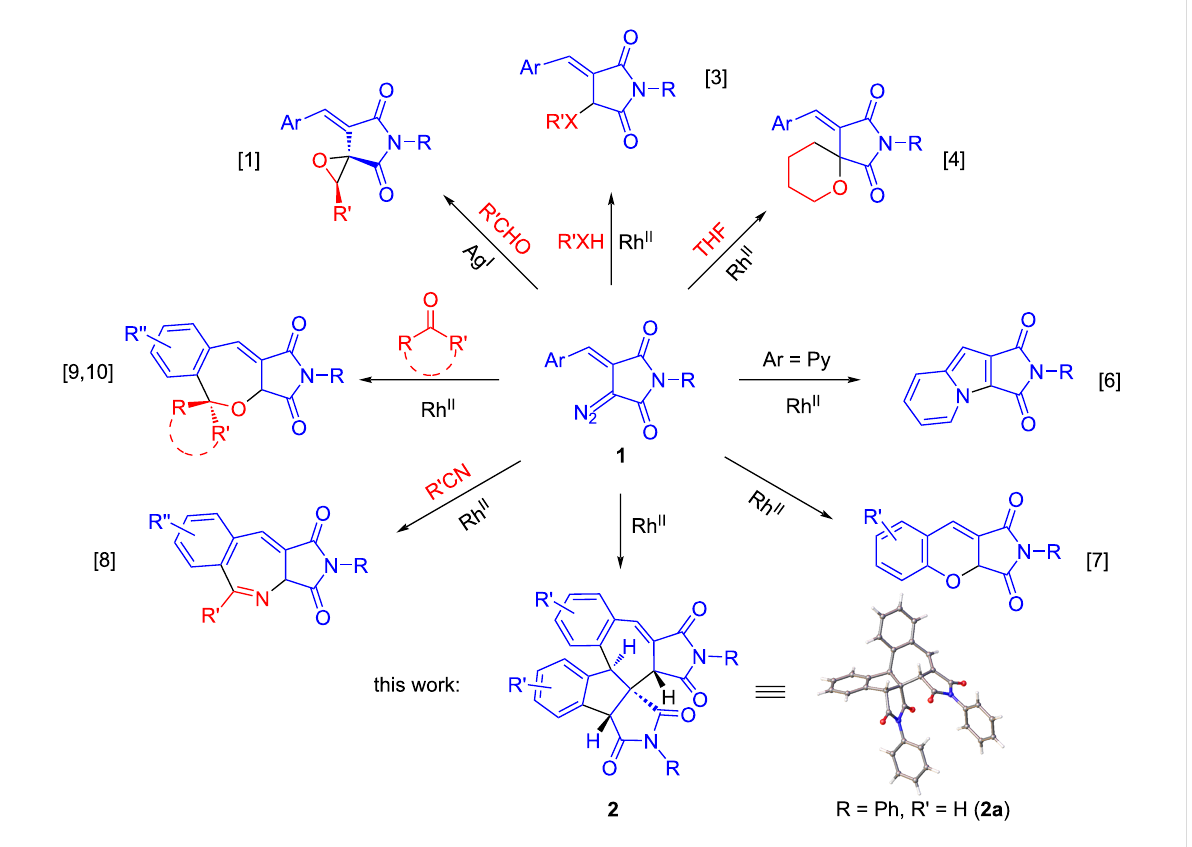
Figure 1: Previously reported transformations of DAS ( 1 ) and their unusual dimerization investigated in this